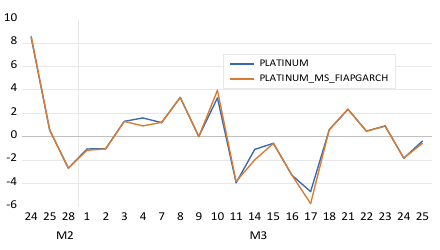
Figure 8. Platinum, MS − FIAPGARCH.